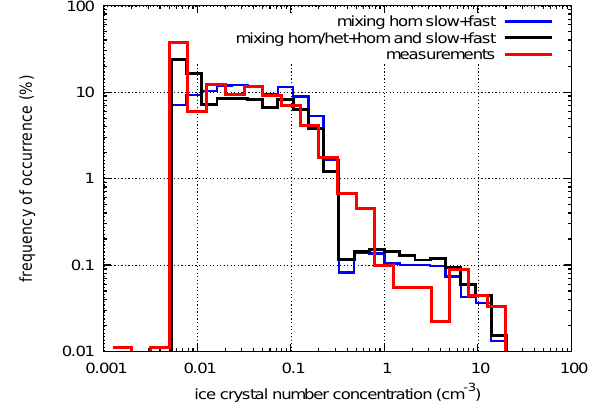
Fig. 11. Frequency of occurrence of ice crystal number concen- trations: mixture of simulations in very slow ( w LS ≤ 1cms − 1 ) and faster ( w LS > 1cms − 1 ) large-scale motions with homogeneous freezing (hom, blue) and with heterogeneous+homogeneous freez- ing (hom/het+hom, black); the red line represents the measurements of Krämer et al. (2009); the lowest concentration bins of the model simulations are clipped off for a better comparison with the mea-